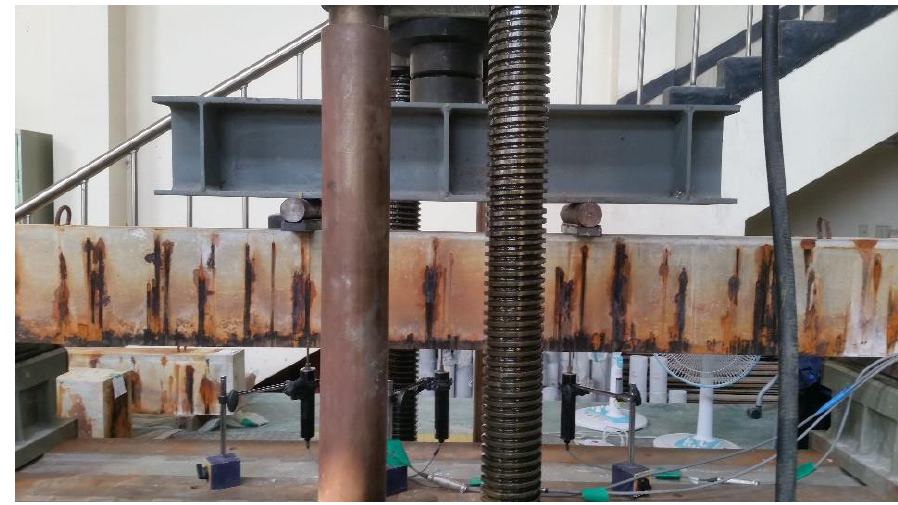
Figure 6. Test setup.